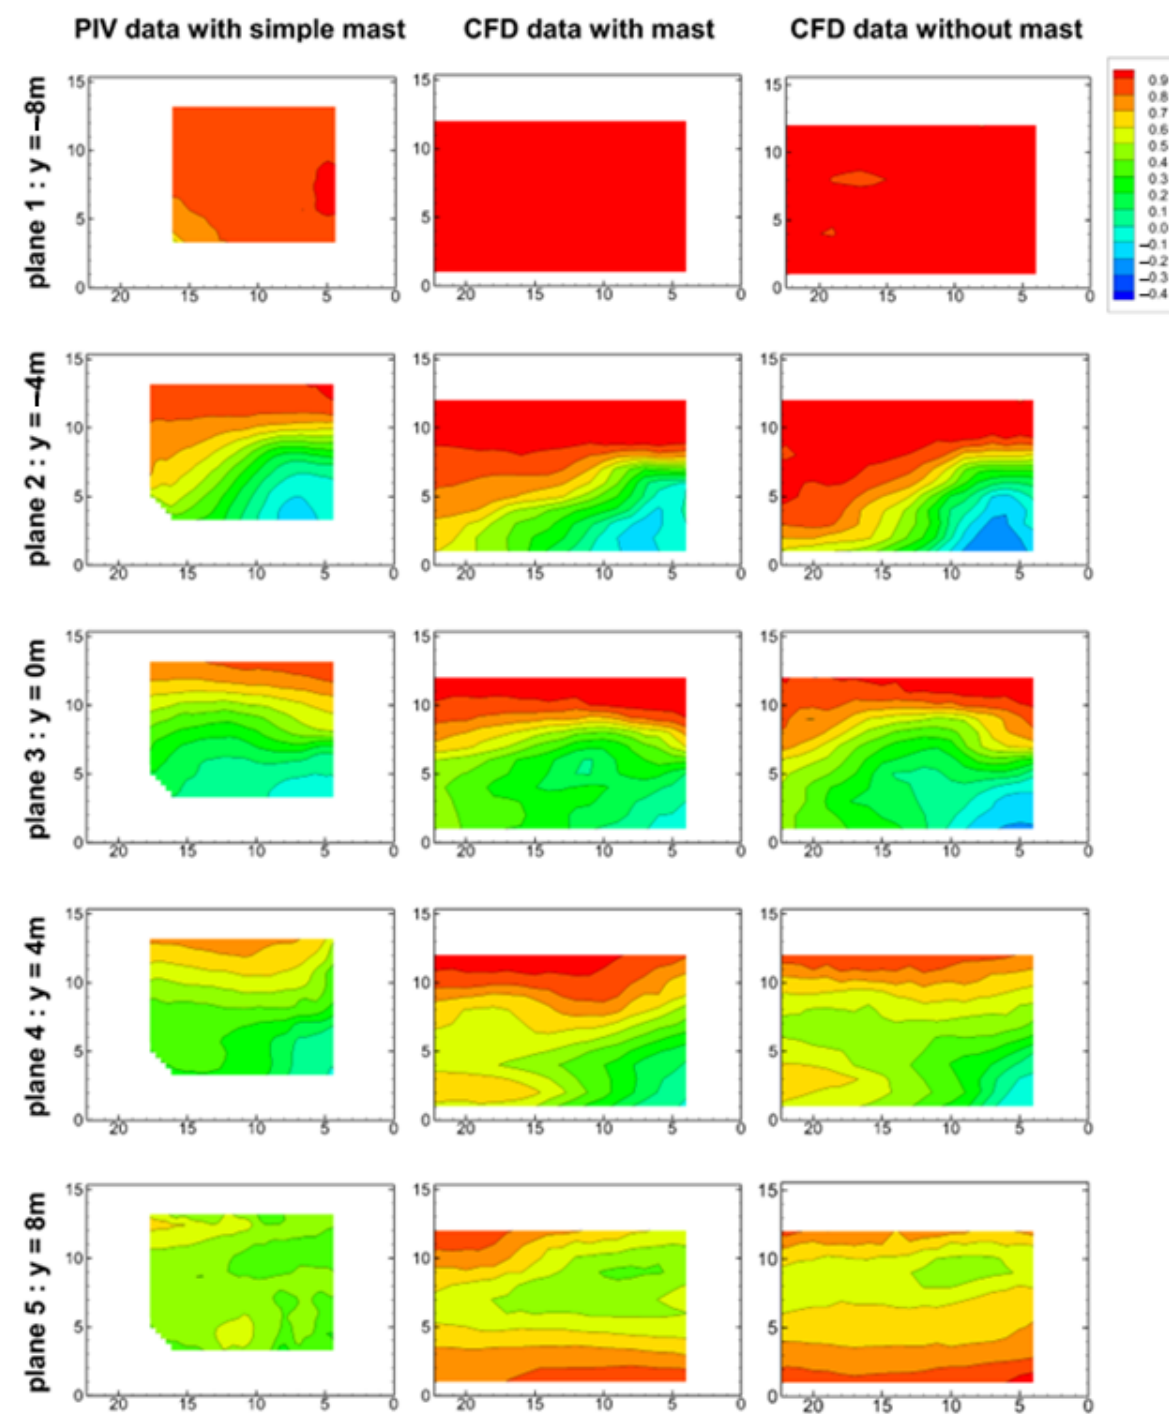
Figure 8. CPF airwake data on x-z planes at constant y-coordinates, longitudinal mean flow, head- wind, flow from right to left, and dimensions in meters, and the coordinate origin is located on the centreline of the flight deck at the intersection of the flight deck surface and the aft face of the hangar as shown in Figure 2c,d.